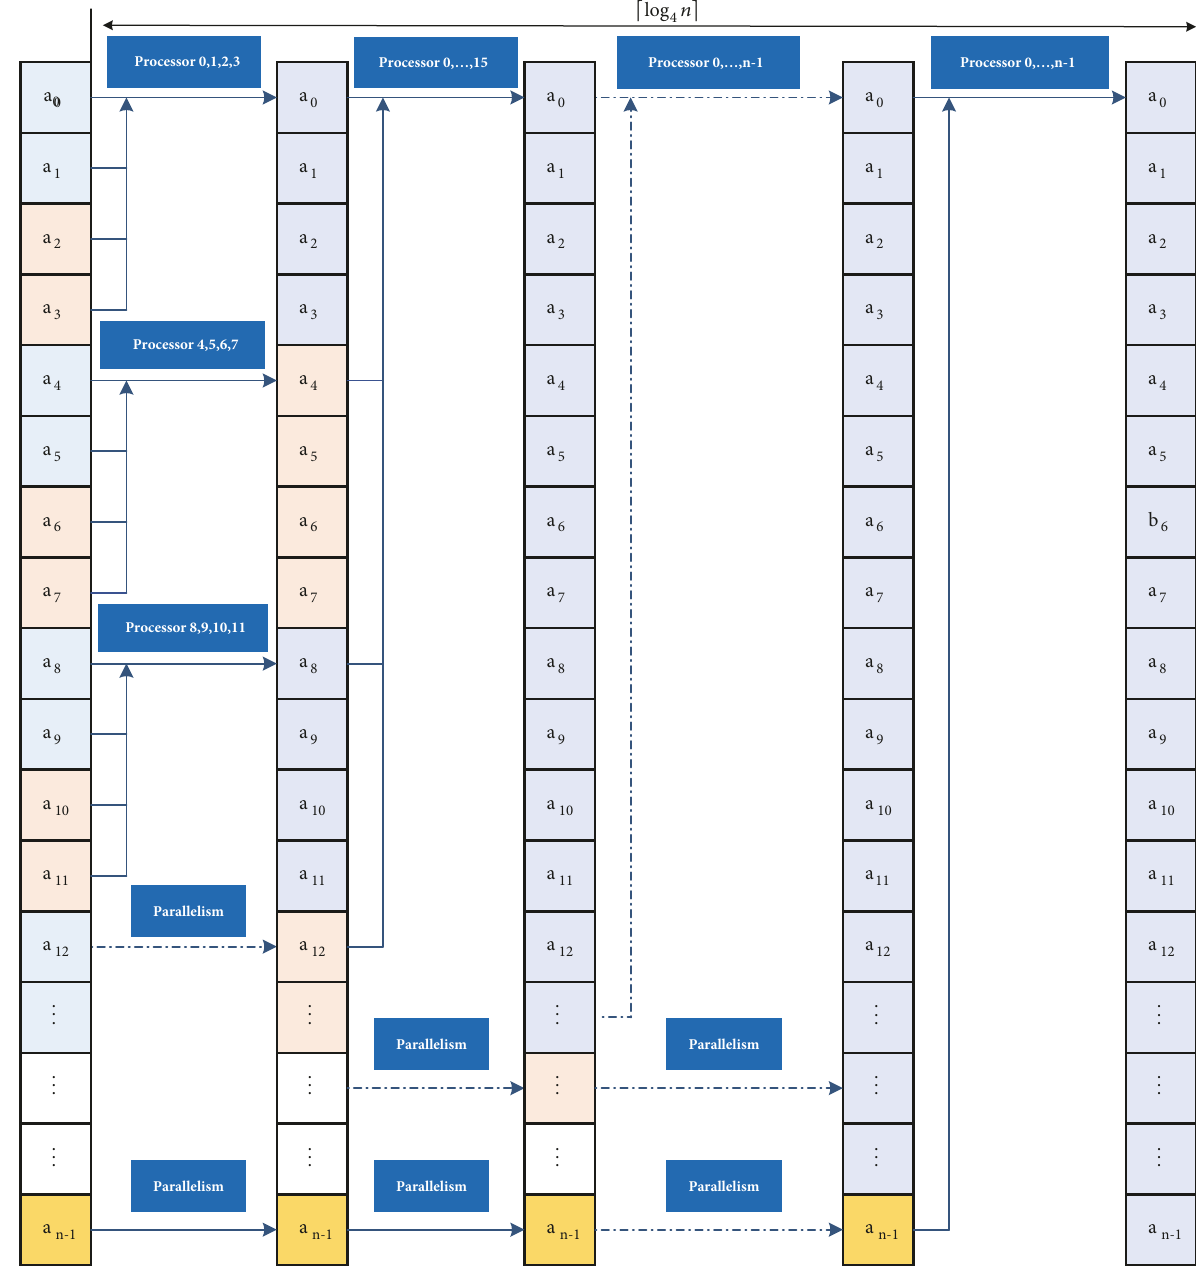
Figure 8: Fully Flexible Parallel Merge Sort